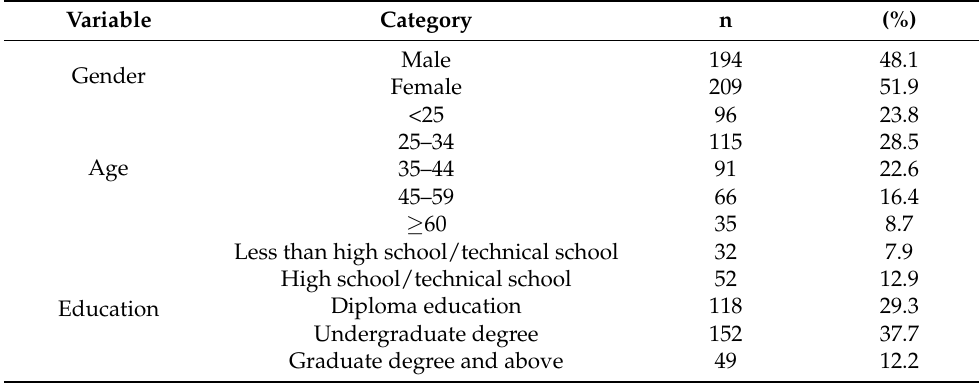
Table 1. Profile of the